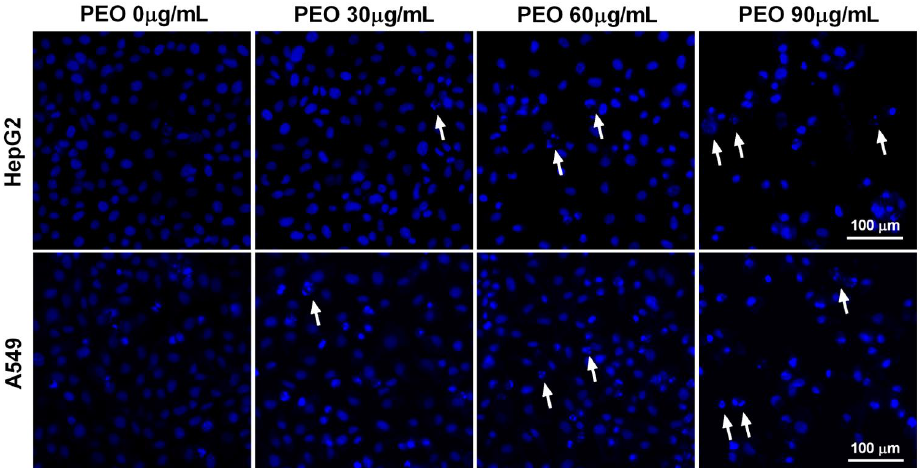
Figure 5. Apoptosis-inducing effect of PEO in HepG2 and A549 cells stained with Hoechst 33342. HepG2 and A549 cells were treated with or without different concentrations of PEO (30, 60, and 90 PBS, the cells were photographed using ImageXpress Micro Confocal High-Content Imaging